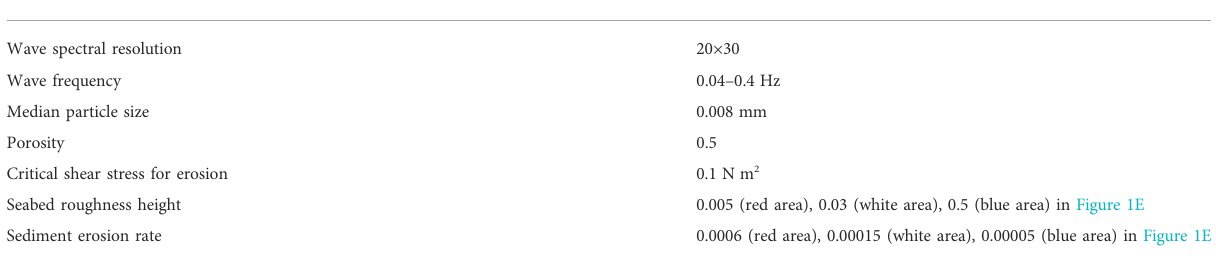
TABLE 1 Main parameters of the sediment and wave models.